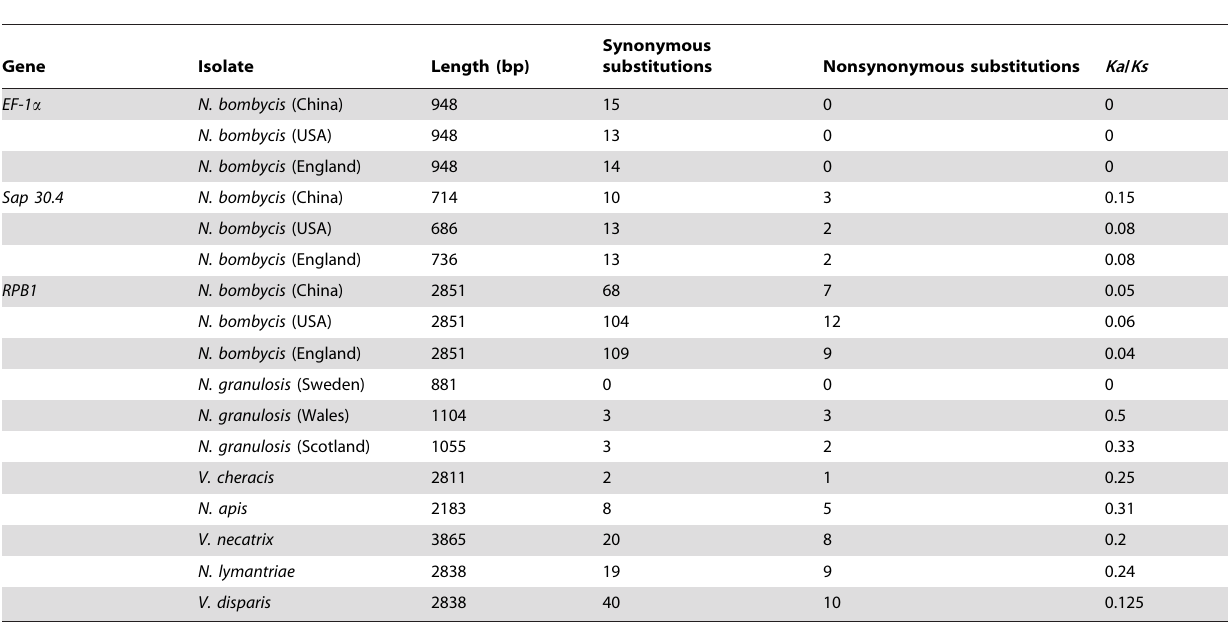
Table 4. Synonymous and nonsynonymous substitutions detected by direct sequencing of protein-coding genes from Nosema isolates.